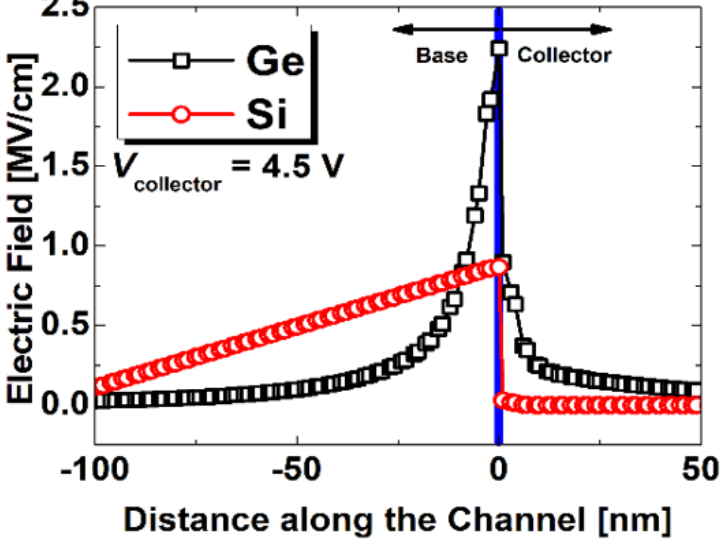
Figure 6. 2-D SILVACO device simulation data showing e-field near the collector region of the Si and Ge biristor.